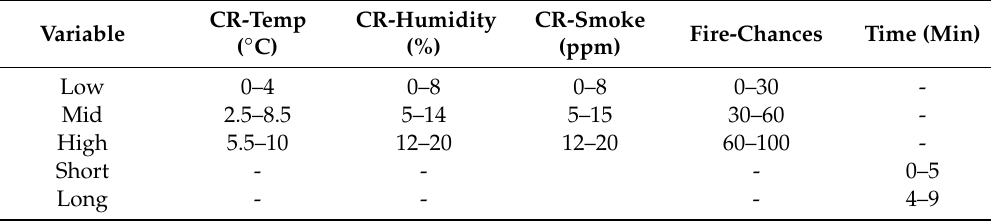
Table 4. The universe of discourse for each membership